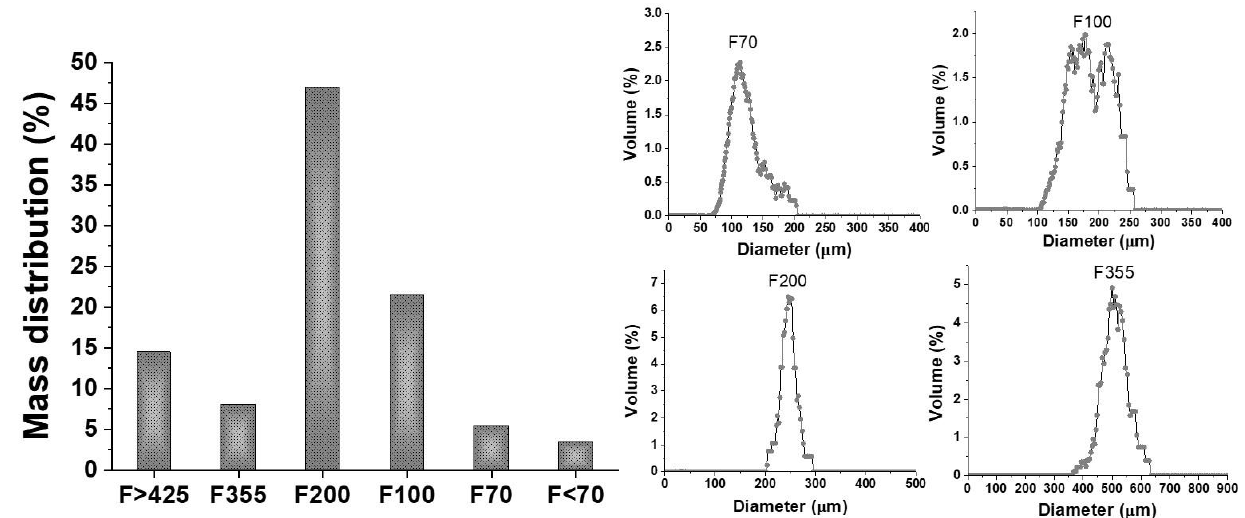
Figure 1. Mass distribution and size polydispersity of each sand fraction.